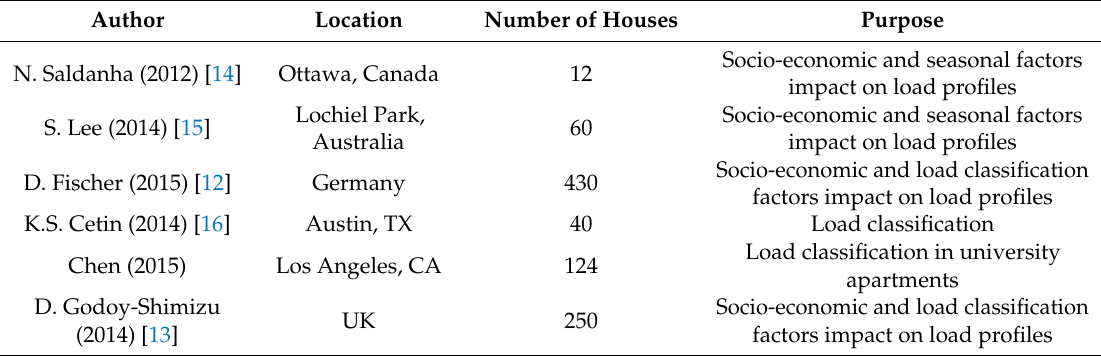
Table 2. A selection of studies that focus on load profiling and factors that influence the load